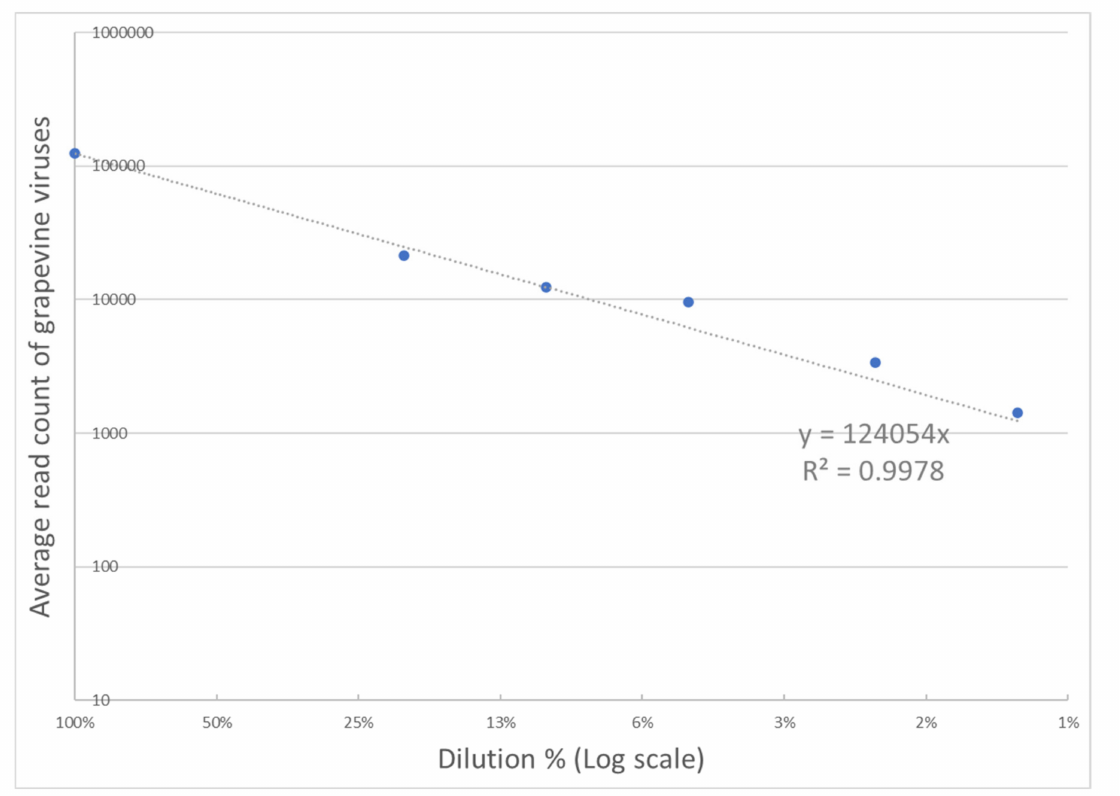
Figure 2. Impact of dilutions on grapevine virus read counts. The average count of reads mapped to grapevine virus sequences is averaged for and plotted against dilution. Regression through the origin demonstrates a high degree of linearity (R 2 >